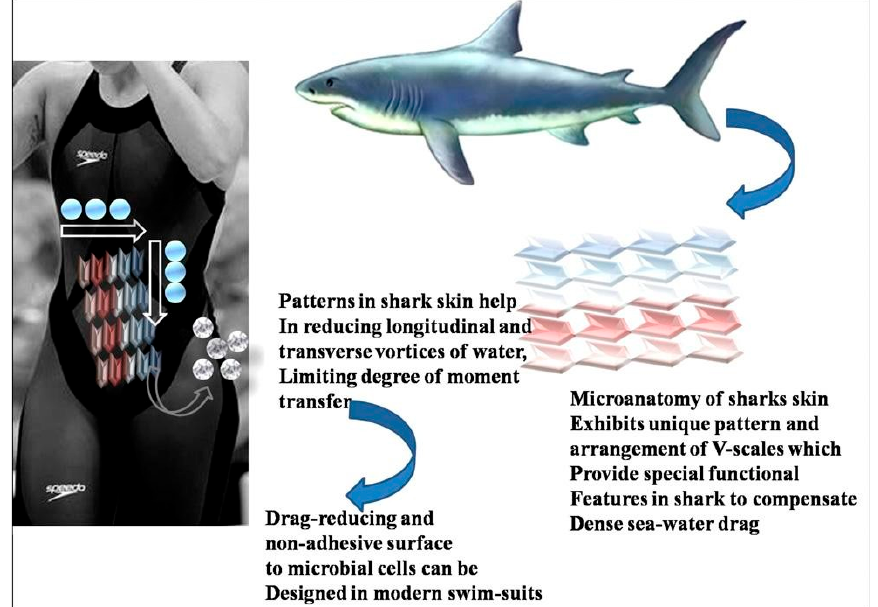
Figure 7. Shark skin’s low hydrodynamic surface drag is an inspiration for the design of high-performance swimwear with an antibacterial effect. The surface drag of water is significantly reduced by nature’s distinctive microscale design (Riblet effect). Arrows depict anti-microbial traits that resemble the micro-topography of a shark’s skin [192]—copyright permission from Elsevier, 2012.